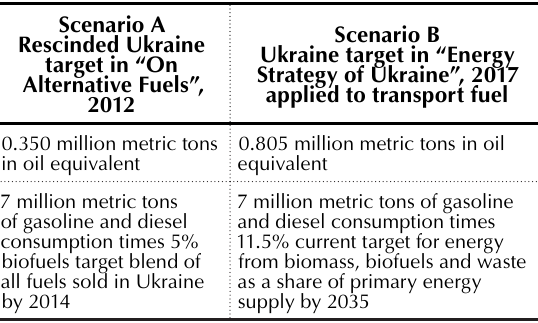
Table 2. Scenarios for biofuels share of Ukraine’s transport fuel consumption by 2035